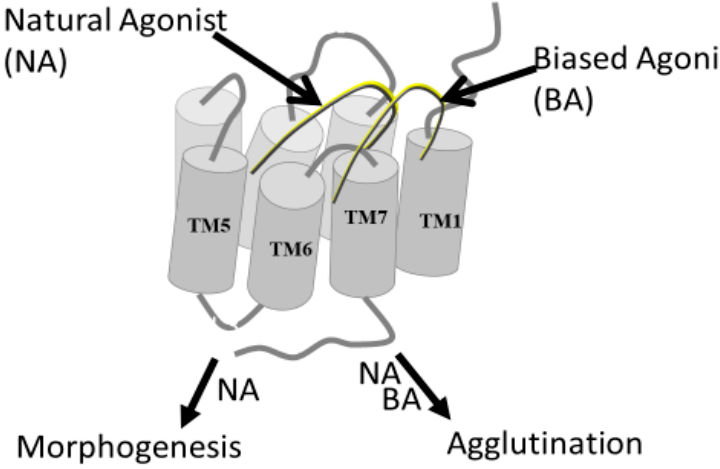
Figure 4. Biased agonism. This diagram shows two peptides, one the naturally occurring α -factor, a normal agonist (NA), and the other a biased agonist (BA) that preferentially initiates different signaling pathways (morphogenesis or agglutination). The BA initiates agglutination at a much lower concentration than that of NA, whereas the NA initiates both similarly [44].